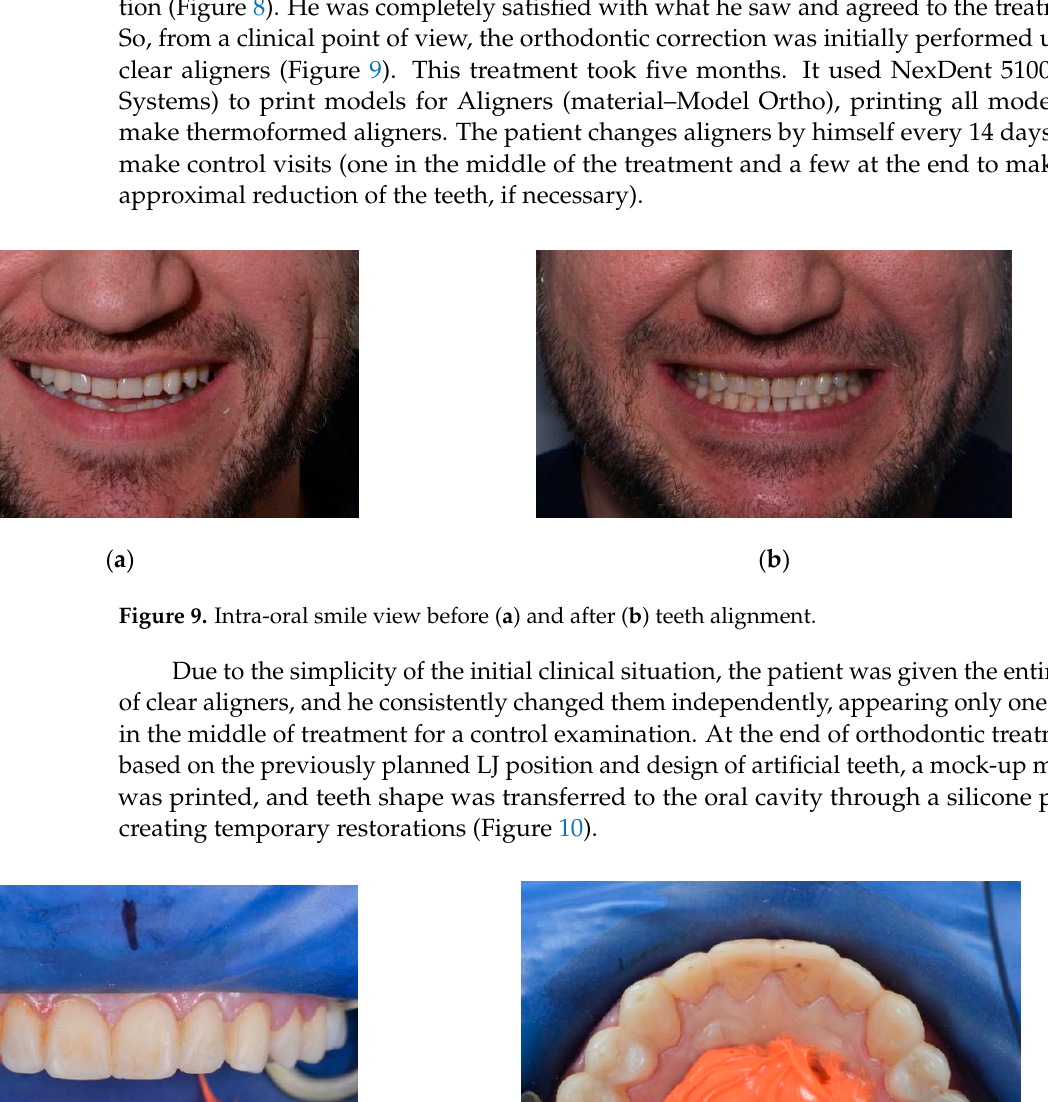
Figure 10. Frontal ( a ) and occlusal ( b ) view of teeth mock-up.